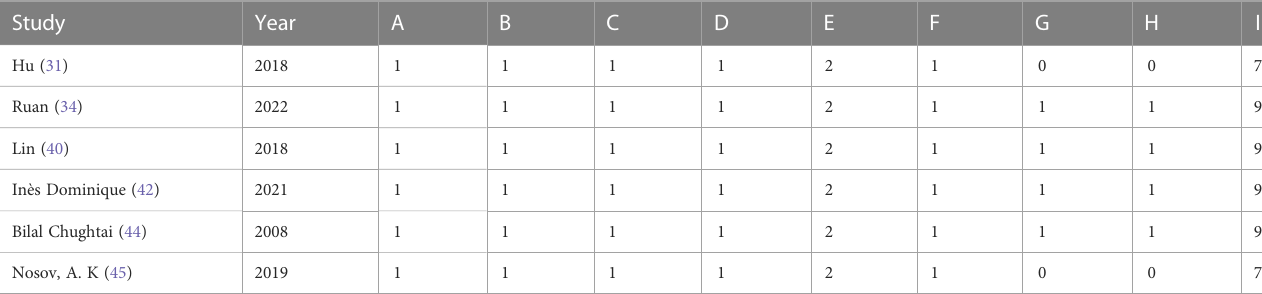
subgroup of laparoscopic surgery (WMD=-3.00, 95% CI: -4.03 to Total hospitalization time Four studies reported total length of stay, involving a total of 495 patients (253 patients in the ERAS group and 242 patients in the routine care group). A fi xed-effects model summary showed that the total length of stay was 3.35 days shorter in the ERAS group compared